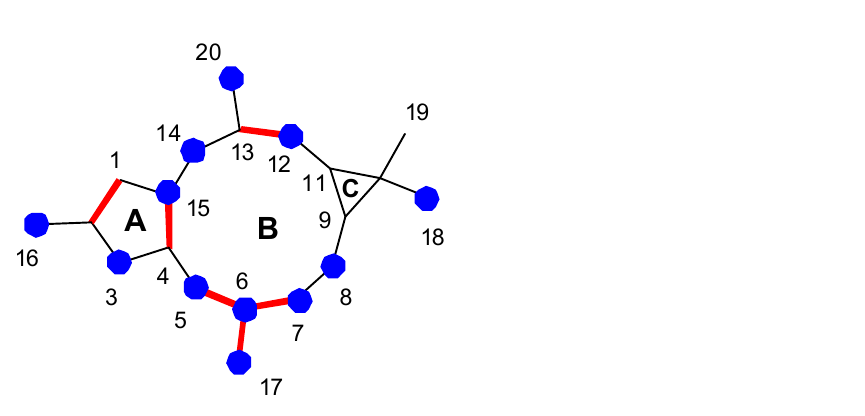
Figure 1. General layout of bioactive lathyrane derivatives, with no stereochemical detail. Carbocyclic rings are labeled with the letters A, B and C. Solid blue dots indicate the positions where an oxygenated functional group has been described (alcohol, ether/epoxide, ester, ketone). Broadened red lines show positions where double bonds have been described.